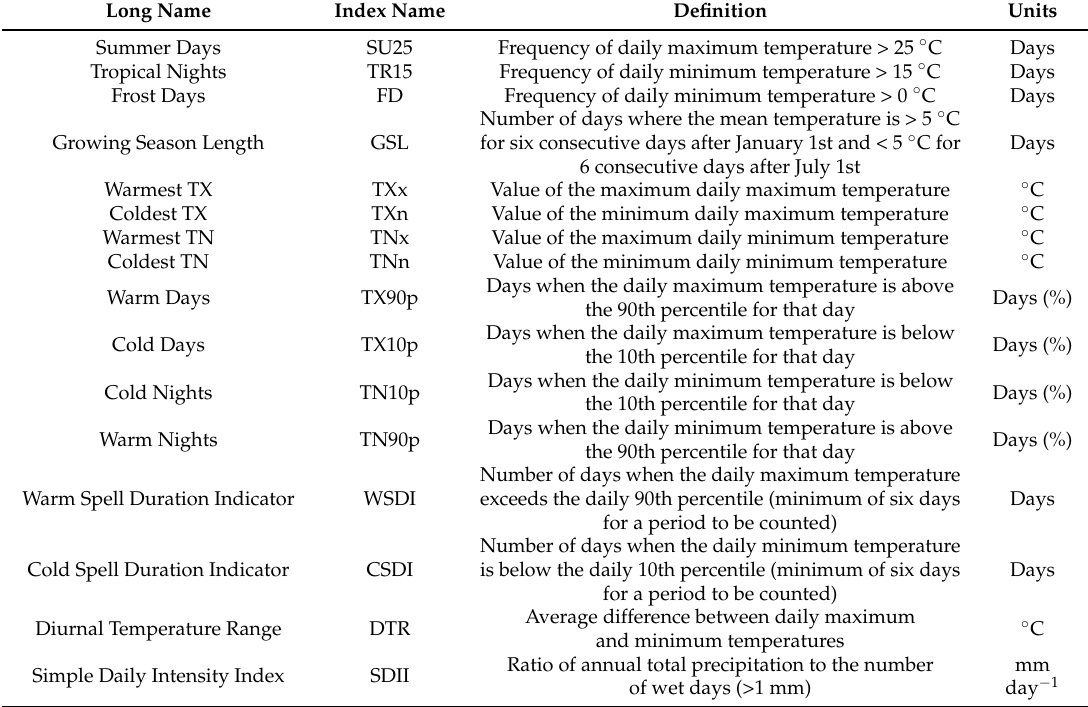
Table 1. The ETCCDI indices used in this study. The Tropical Nights index has been altered from the standard 20 ◦ C (TR20) to 15 ◦ C here (TR15) which is more suitable for the climate of